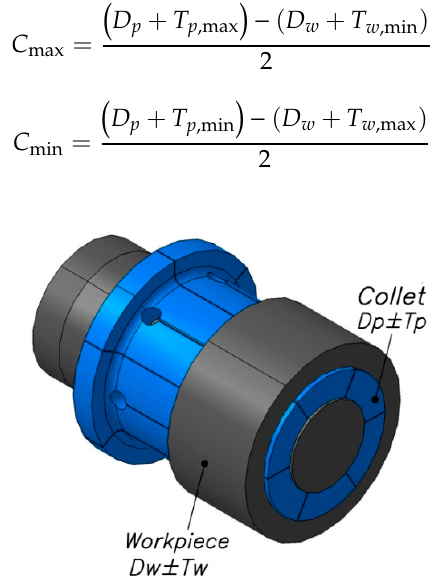
Figure 9. Tolerances of the collet and the workpiece.